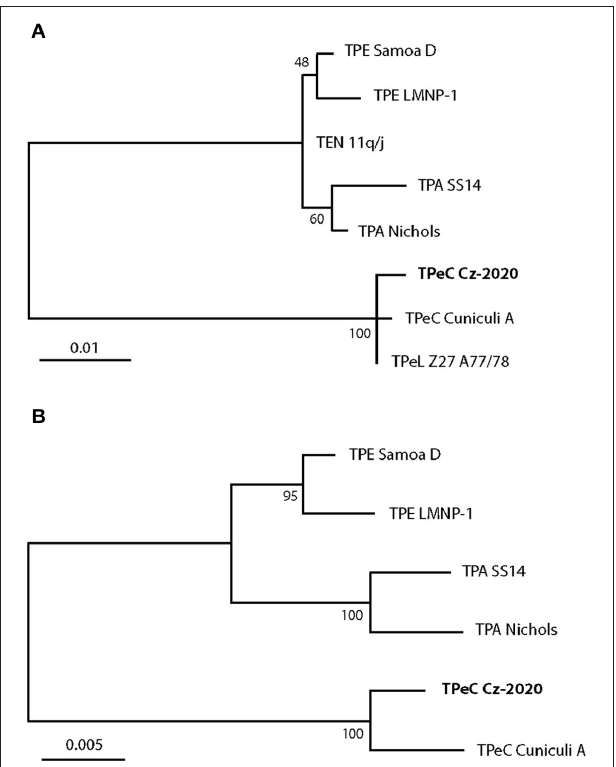
FIGURE 3 | The maximum likelihood phylogenetic analyses of TPeC strain Cz-2020 and selected species of the genus Treponema . ( A , top) The phylogenetic tree is based on the sequence of TP0548 locus showing clustering of TPeC Cz-2020 with TPeC Cuniculi A and with TPeL Z27 A77/78 (the agent of hare syphilis) (9). Treponema pallidum ssp. endemicum (TEN) 11q/j ( 32–34) was used because other characterized TEN strains (i.e., Bosnia A and Iraq B) contain a putative recombination event at the TP0548 locus ( 32). There was a total of 619 positions in the final dataset. All positions with < 95% site coverage were eliminated. The scale shows the number of substitutions per site. ( B , bottom) The phylogenetic tree based on concatenated sequences of TP0105, TP0488, TP0548, and TP0705 loci. TEN subspecies and TPeL are not shown because sequences of TEN 11q/j and TPeL are not available for all these loci. TPeC Cz-2020 is clustered with TPeC Cuniculi A but is still genetically quite distinct. There was a total of 2,945 positions in the final dataset. All positions containing gaps and missing data were eliminated. The scale shows the number of substitutions per